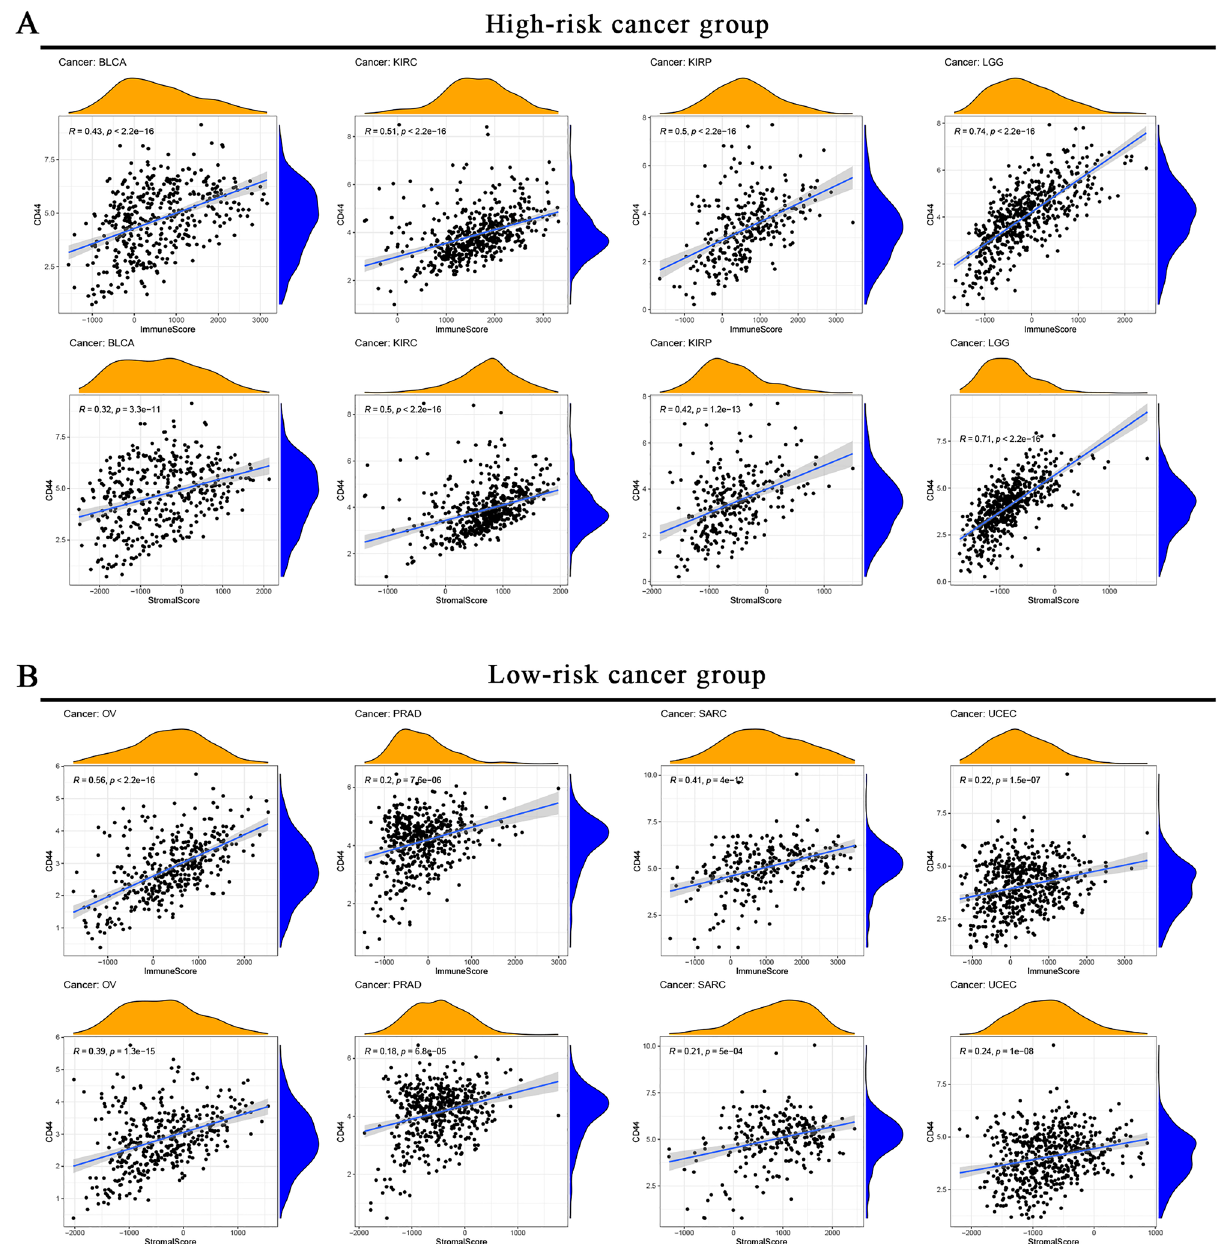
Figure 3. Correlation between CD44 expression and different components in the high-risk cancer group ( A ) and low-risk cancer group ( B